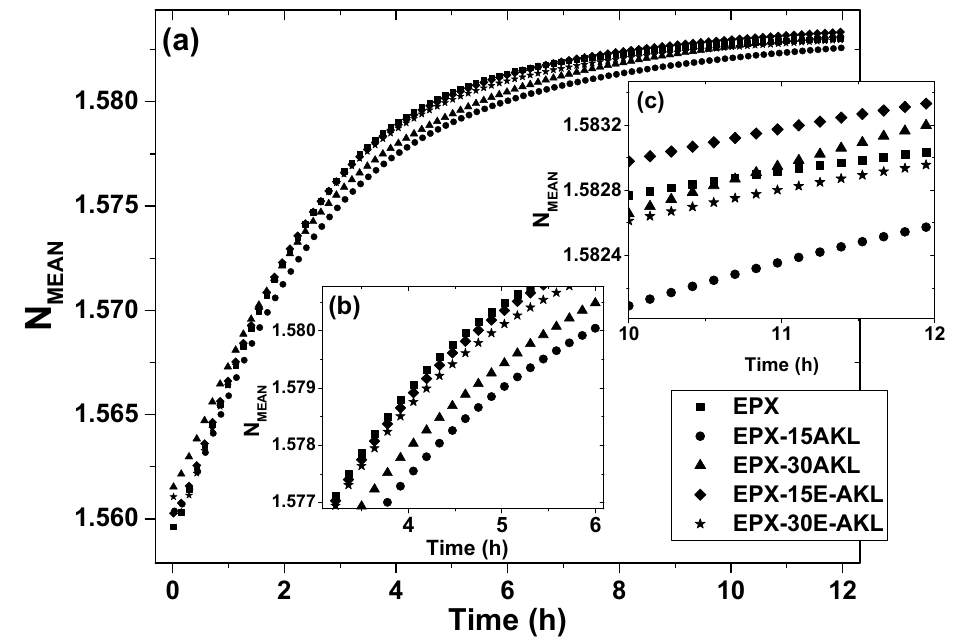
Figure 6. Temporal evolution of ( a ) the average refractive index (N MEAN ) of all samples. Inset: ( b ) A zoomed-in representation of the early stages of the reaction (between 3 and 6 h). And ( c ) a zoomed-in representation of the final region (between 10 and 12 h).